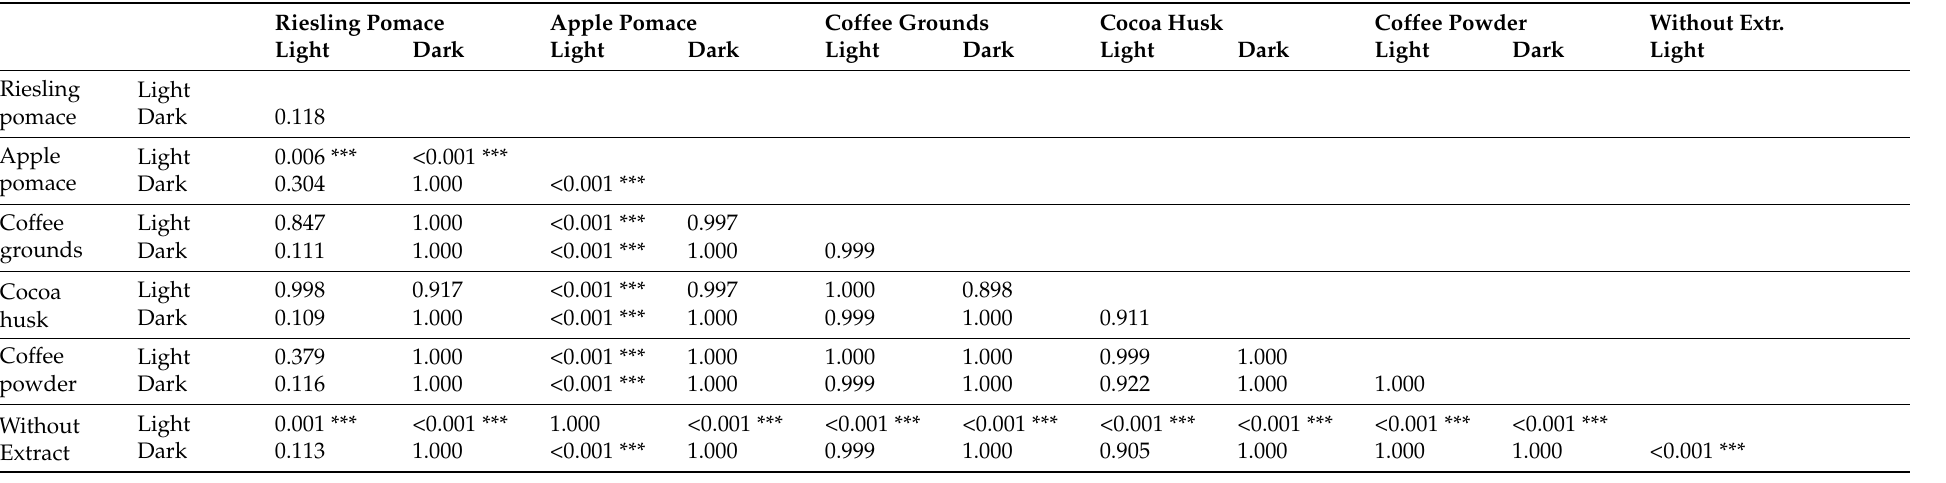
Table 6. p -Values of all pairwise multiple comparison procedures (Holm–Šid á k method) of the concentration of hexanal in O/W emulsions with plant extracts (significance *** p <